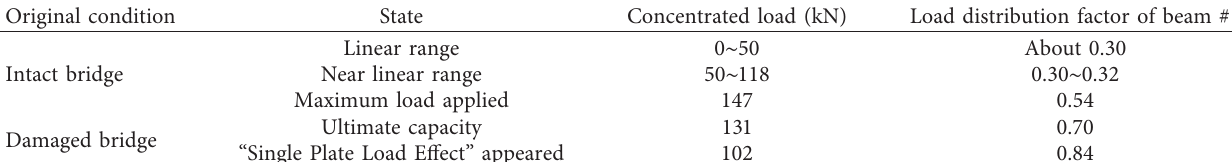
Table 3: Change of DDF at different load stages.